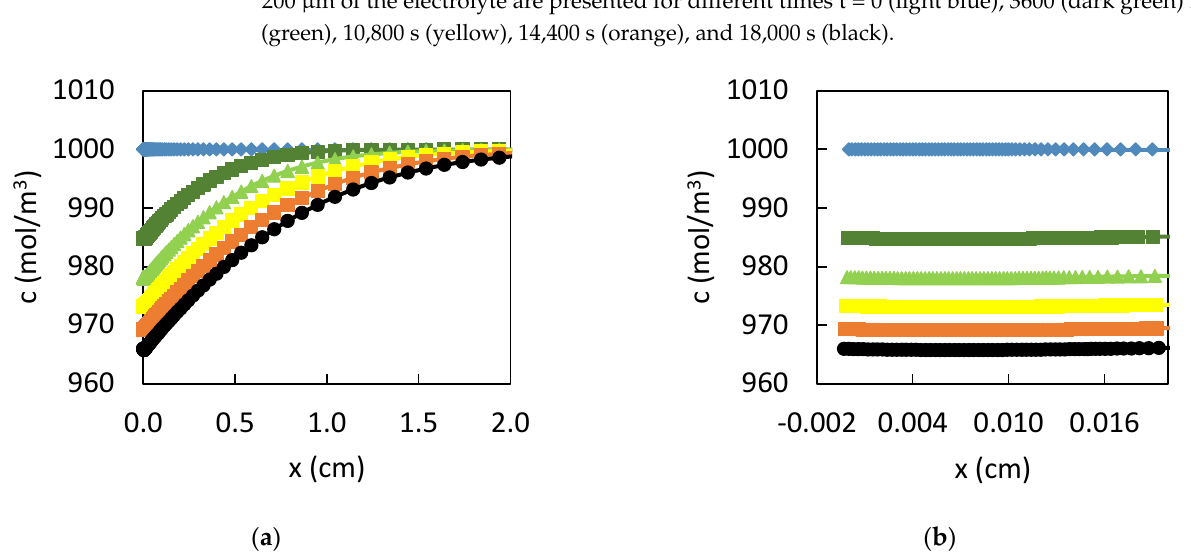
Figure 14. Evolution of the chloride ion concentration in an electrolyte of 1000 mol/m 3 HCl and of size L = 10 cm with an initial CPL of 100 µm and a variable porosity ( a ) the first 2 cm and ( b ) the first 200 µm of the electrolyte are presented for different times t = 0 (light blue), 3600 (dark green) 7200 s (green), 10,800 s (yellow), 14,400 s (orange), and 18,000 s (black).